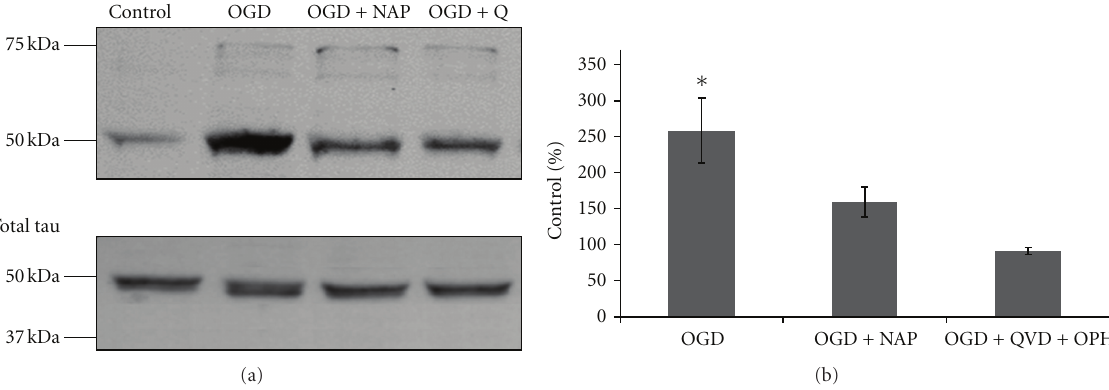
Figure 5: 2 hours of OGD caused an increase in p-tau 202 levels, prevented by either NAP or QVD-OPH treatment. Cultures were treated with 10 − 5 M NAP or with 20 μ M QVD-OPH (broad spectrum caspase inhibitor, indicated as OGD + Q) and exposed to OGD insult for 2 hours. Proteins were extracted and analyzed using immunoblot with a specific anti-p-tau 202 and antitotal tau antibodies. A representative blot of p-tau 202 and total tau is exhibited in (a). P-tau levels were quantified and normalized to total tau levels (ANOVA with post hoc LSD, P ≤ 0 . 05)